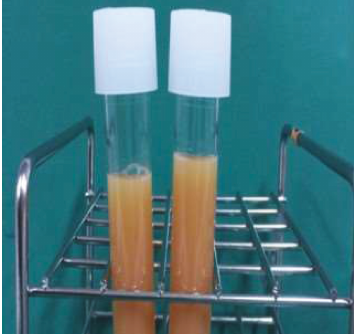
Figure 2: Appearance of bilateral pleural e ff usion of the chest was lightly bloody and chylous from each thoracic cavity.